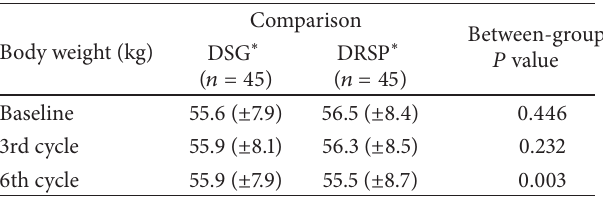
Table 7: The comparison of the body-weight change between both